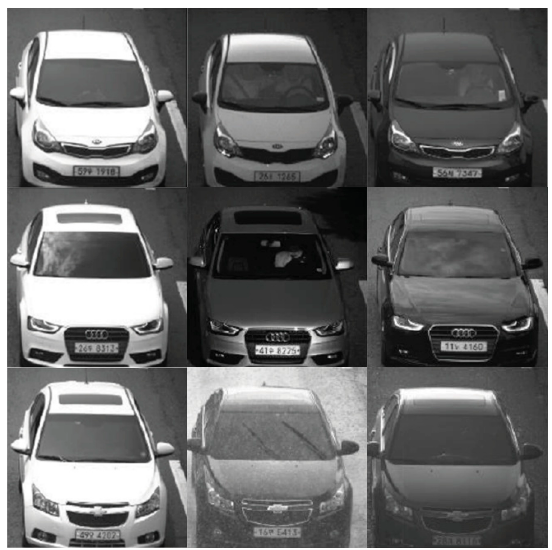
Figure 6. Examples of clustered images.